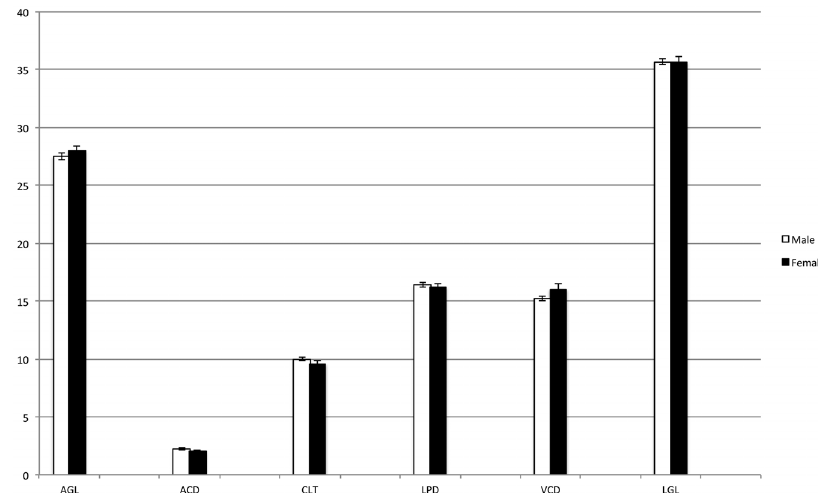
Figure 2. Intraocular measurements in relation to gender. No significant differences were detected. Males (white columns); females (black columns). AGL=axial globe length; ACD=anterior chamber depth; CLT=central lens thickness; LPD=lens poles distance; VCD=vitreous chamber depth; LGL=longitudinal globe length.